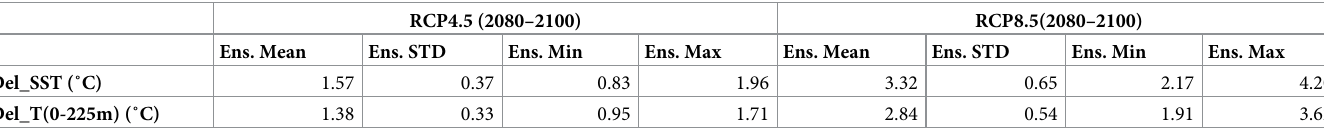
Table 3. Ensemble results for the basin averaged SST anomalies in the Red Sea (in ˚C) at the end of the century (2080–2100). The ensemble mean and spread (STD) along with the ensemble minimum and maximum values are presented for scenario RCP4.5 and